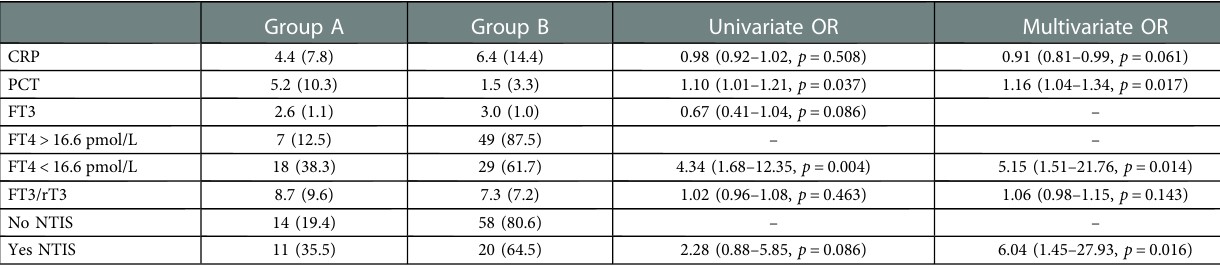
TABLE 4 Odds ratio (OR) of the univariate and multivariate regression